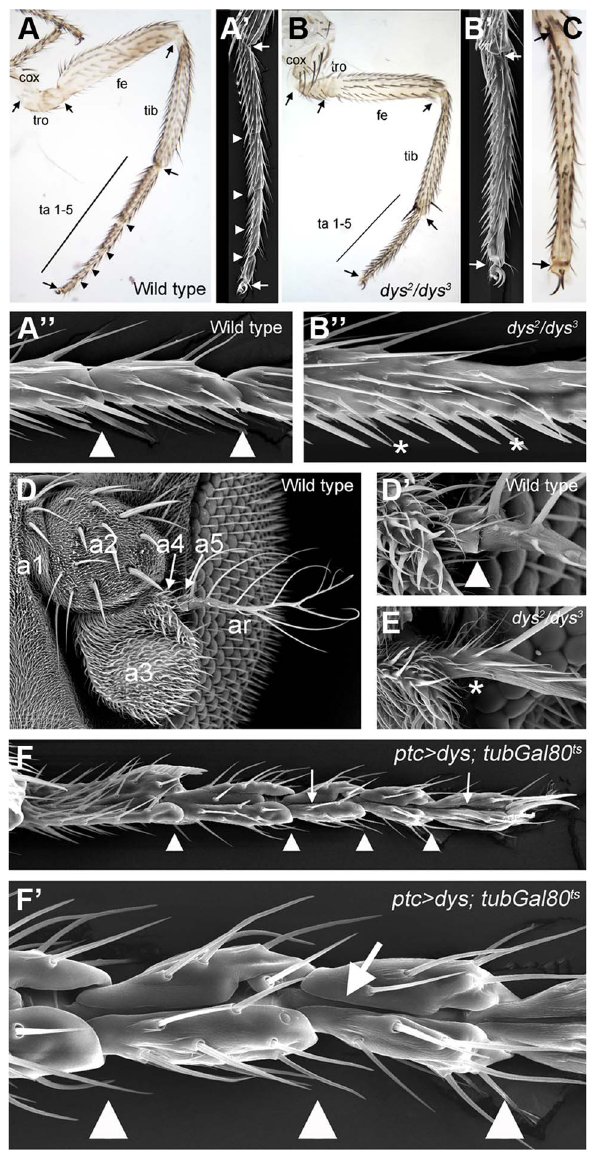
Figure 2. dys loss and gain of function phenotypes. (A) Adult leg of a wild type female, where the distal joints (arrowheads) and the ‘‘true’’ joints (arrows) are pointed out. (A 9 and A 0 ) Scanning Electron Microscopy (SEM) imaging of wild type legs. Close view of wild type tarsal joints is shown in A 0 . (B) Adult leg of a dys 2 /dys 3 mutant female. Note the complete absence of tarsal joints while the ‘‘true’’ joints are not affected (arrows). (B 9 and B 0 ) dys 2 /dys 3 mutant leg, and a close view of the tarsal region (B 0 ). Note the lack of tarsal joints (asterisks). (C) Dll- Gal4 ; UAS- dys -RNAi female leg without tarsal joints. As in the dys 2 /dys 3 mutant leg, the tibial/tarsal and tarsal/pretarsal joints are not affected (arrows). (D) Wild type antenna, with antennal segments marked. (D 9 ) Close view of the wild type a5/arista joint. (E) In a dys 2 /dys 3 mutant antenna the a5/arista joint is missing (asterisk). (F and F 9 ) Male adult leg of a ptc - Gal4 ; UAS- dys ; tubGal80 ts fly. Ectopic expression of dys along the PD axis of the leg induced the formation of a fold (arrows). Arrowheads indicate normal position of tarsal joints. abolish joint formation in the tarsal segments without affecting the tibial/tarsal or tarsus/pretarsus joints just as described for dys 2 / dys 3 mutant legs (Figure 2C).